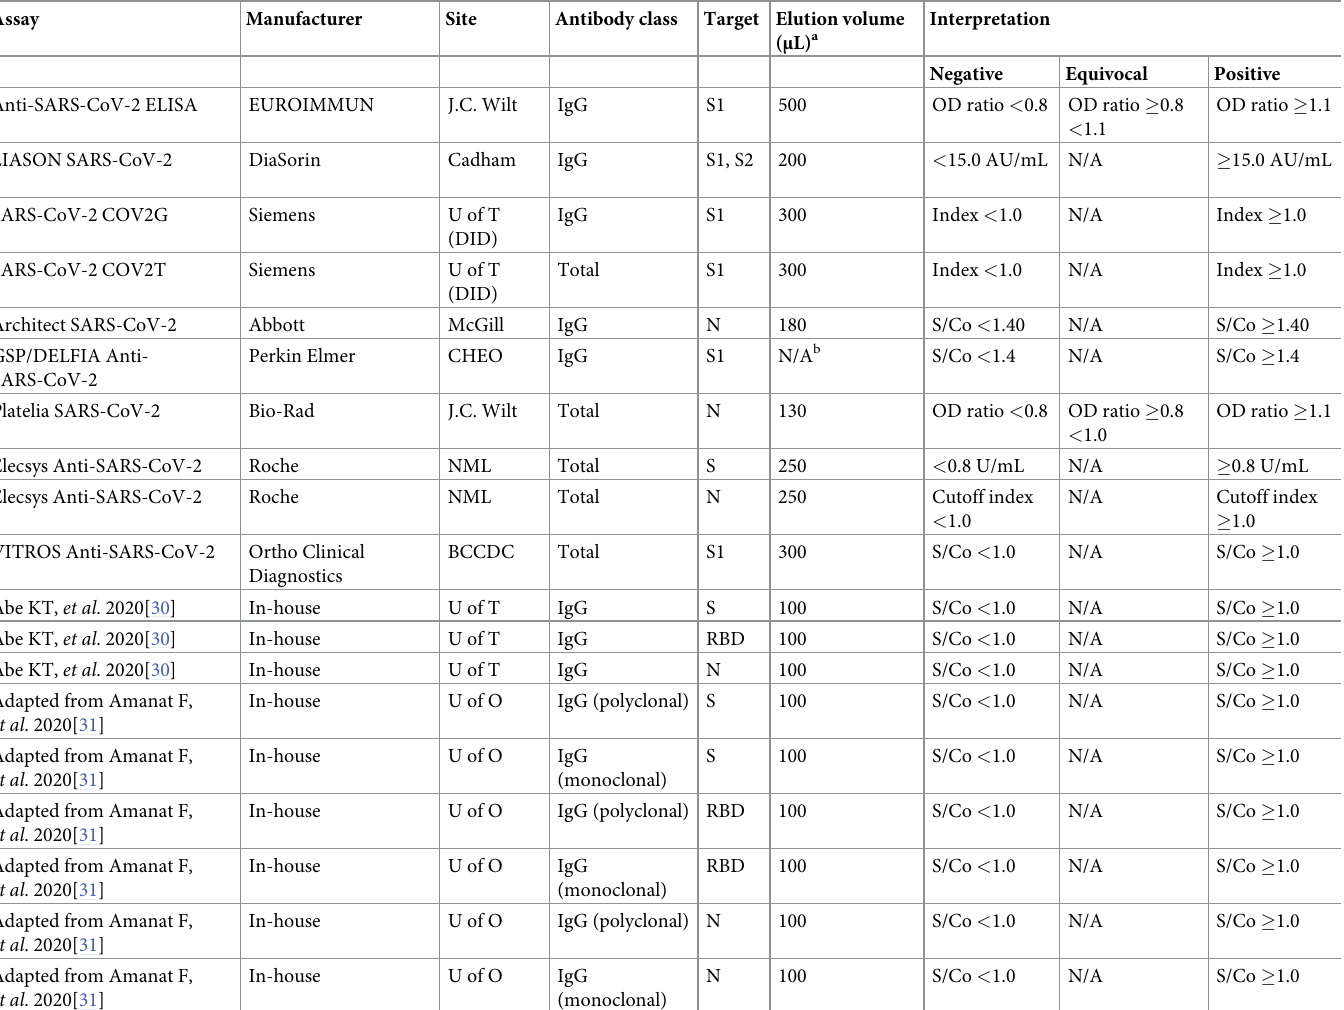
Table 4. Commercial and in-house serological tests assessed for SARS-CoV-2 antibody testing on dried blood spot specimens.